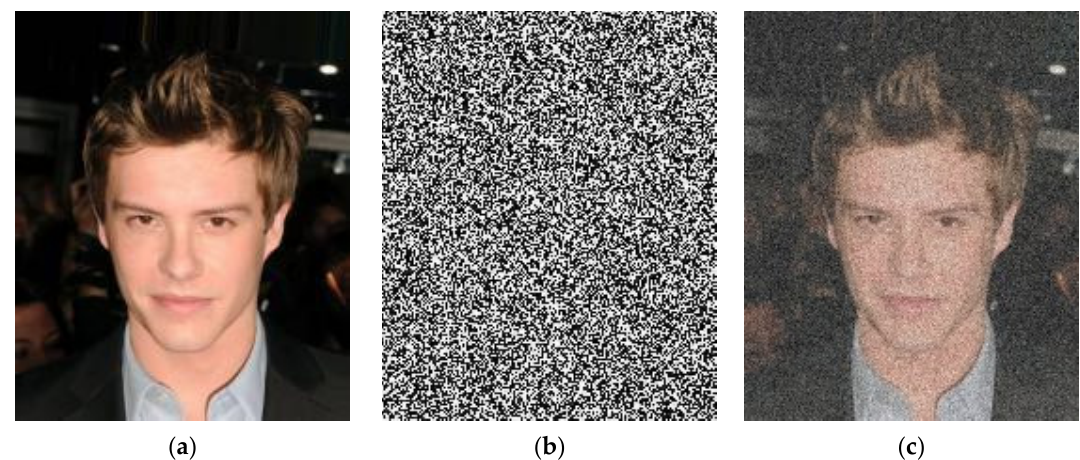
Figure 1. Sample of degraded image. ( a ) presents an original image 𝑦 , ( b ) demonstrates the AWGN image 𝑛 , and ( c ) shows the resultant image 𝑥 = 𝑦 + 𝑛 .